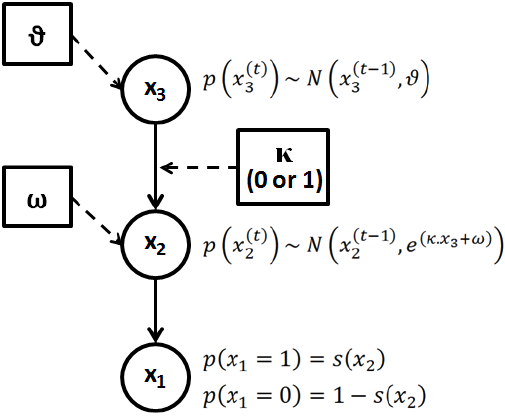
Figure 2. Graphical illustration of the hierarchical perceptual (generative) model with States x , x and x . The probability at each level is determined by the variables and 1 2 3 parameters at the level above. Each level relates to the level below by controlling the variance of its transition probability. The highest level in this hierarchy is a constant parameter, ϑ . At the first level, x determines the probability of the input stimulus: 1 standard (0) or deviant (1). The model parameters, ω and ϑ , control the agent’s belief update about State . Note that setting κ = 0 effectively truncates the hierarchy to the first two levels. In the diagram, squares represent fixed parameters, while circles represent state 𝑥 variables that evolve in